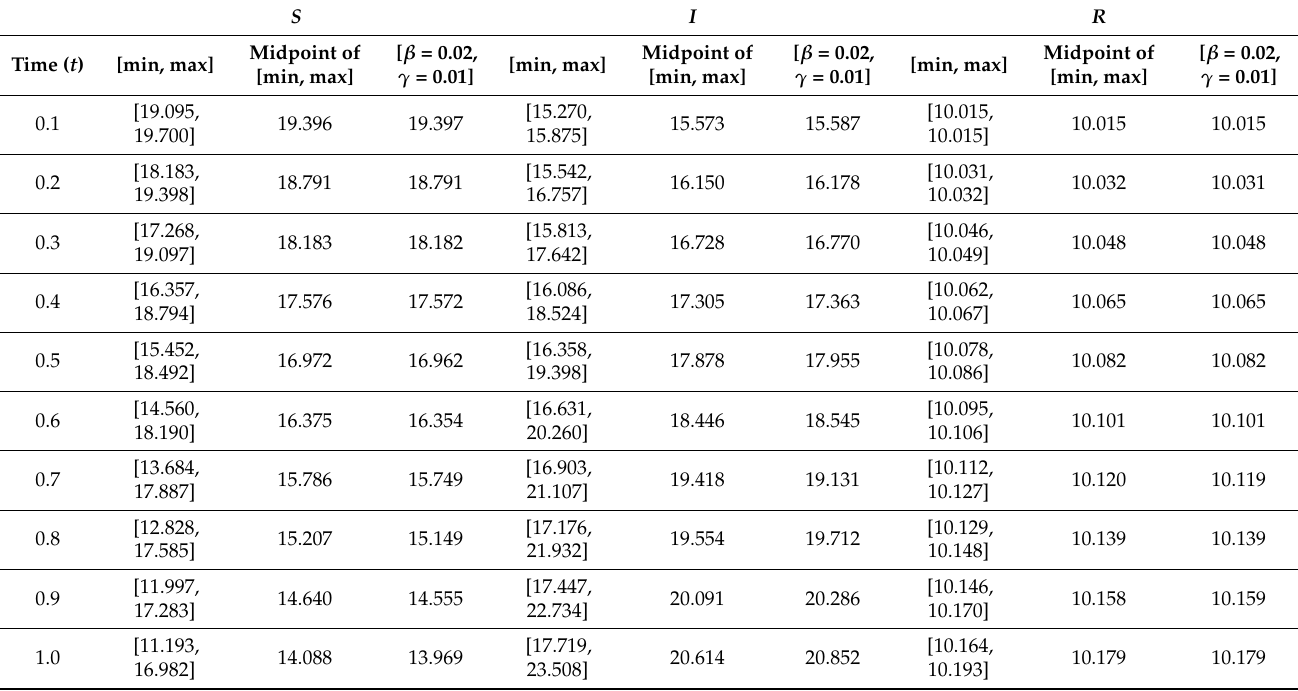
Table A1. The solutions obtained by the homotopy analysis method with the interval (cid:101) β = [ 0.01, 0.03 ] and the constant value of γ = 0.01.